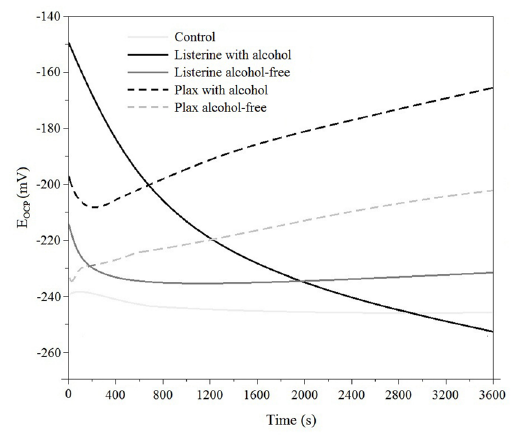
Figure 1. Potentiostatic curves for Co-Cr.